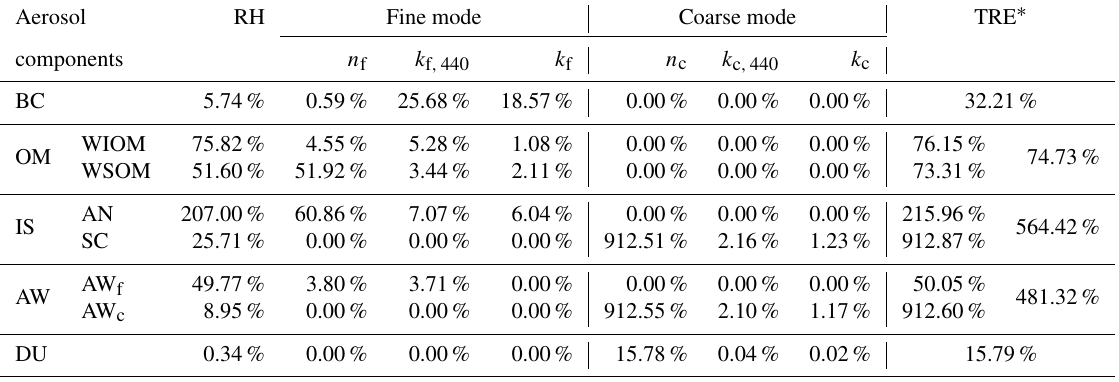
Table 3. Estimated total relative errors (TREs) of aerosol component mass fractions in the three aerosol models used to evaluate the aerosol component classification inversion algorithm.